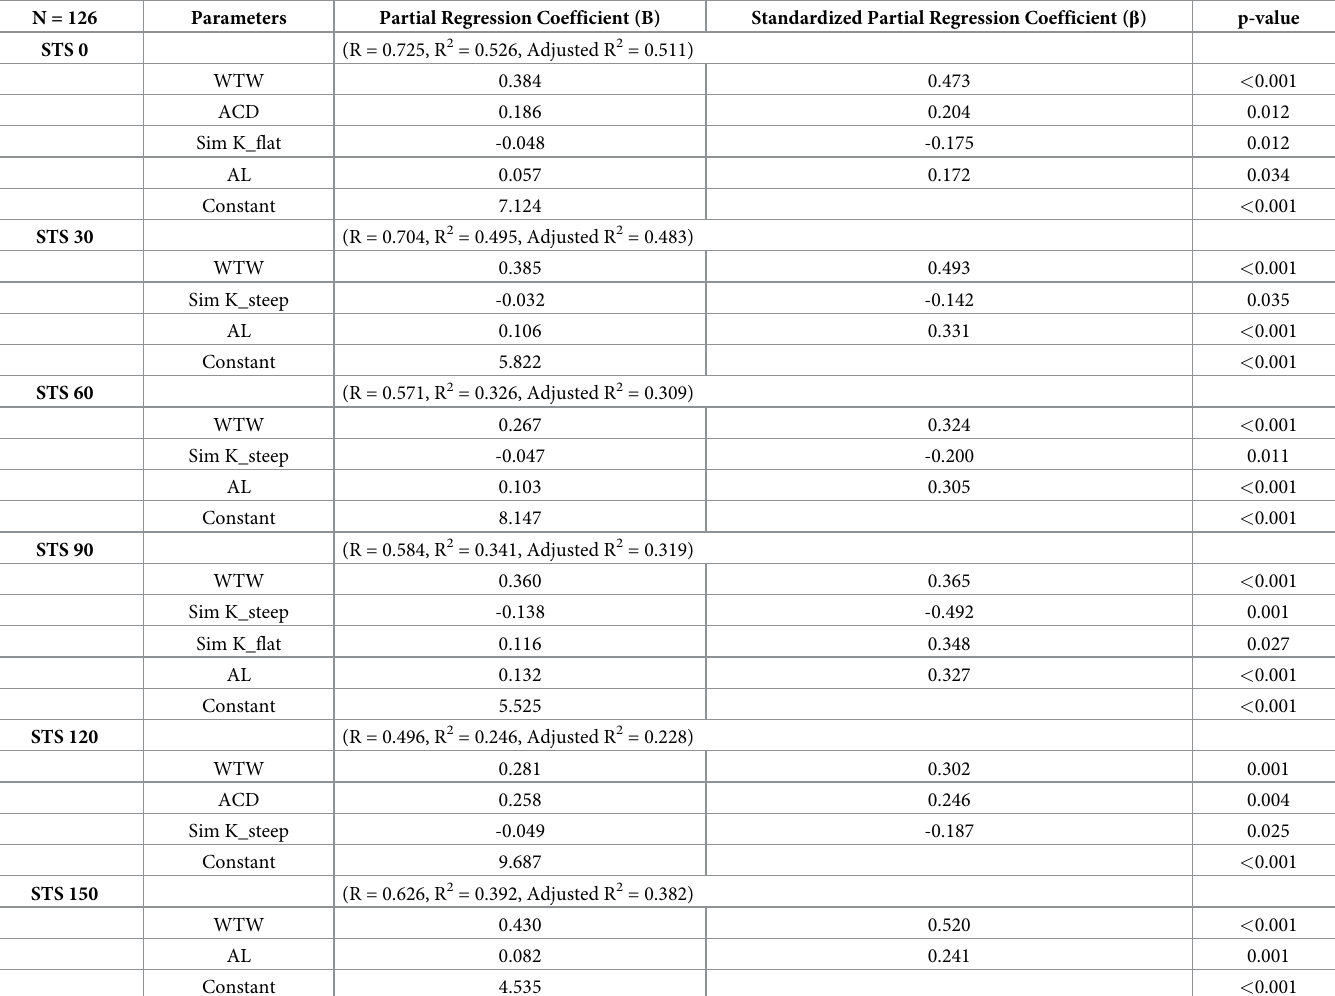
Table 7. Results of the stepwise multivariate regression analysis with age, axial length, manifest refraction spherical equivalent, horizontal WTW, anterior chamber depth, and Sim K (steep and flat) at spur-to spur diameter. N =